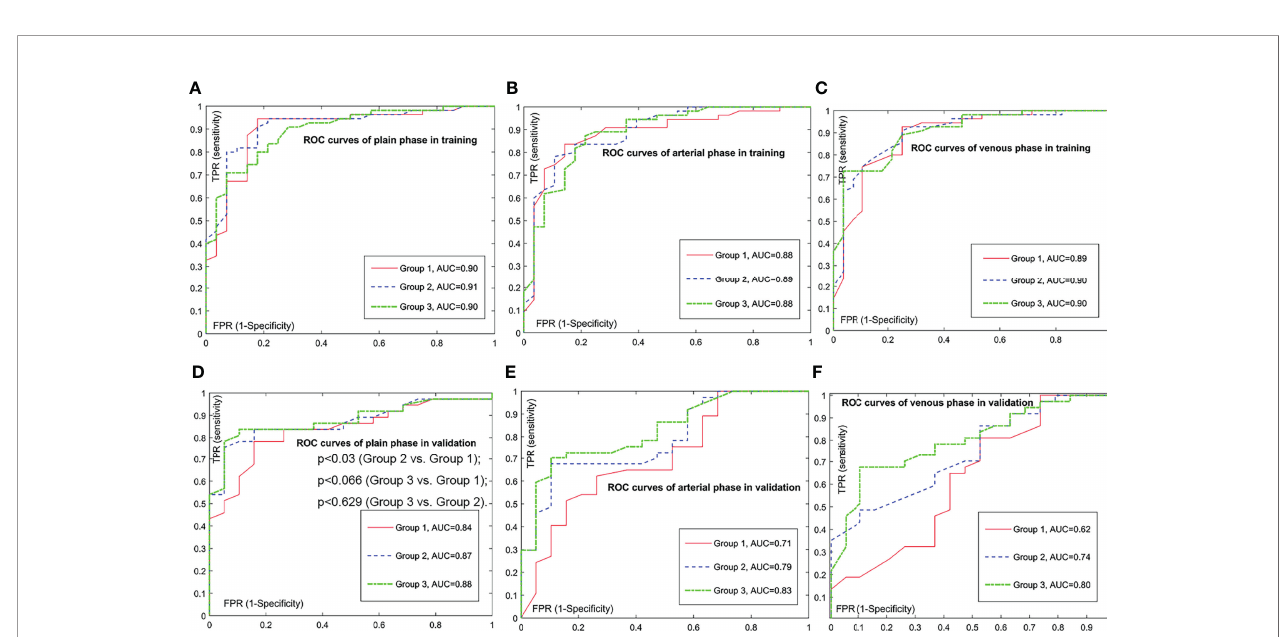
FIGURE 2 | Comparison of receiver operating characteristic (ROC) curves for prediction of the histologic grade. The positive class is grade 2/3; the negative class is grade 1. Sub fi gure (A – C) illustrate the training ROCs. Sub fi gures (D – F) illustrate the validation ROCs. In validations, we performed DeLong ’ s tests to compare two ROC curves. In (D) , the DeLong ’ s tests show that the p -value between the ROC curve of group 3 and the ROC curve of group 1 is less than 0.066, the p -value between the ROC curve of group 3 and the ROC curve of group 2 is less than 0.629, and the p-value between the ROC curve of group 2 and the ROC curve of group 1 is less than 0.030. In sub fi gure (E) , the DeLong ’ s tests show that the p-value between the ROC curve of group 3 and the ROC curve of group 1 is less than 0.003, the p-value between the ROC curve of group 3 and the ROC curve of group 2 is less than 0.037, and the p -value between the ROC curve of group 2 and the ROC curve of group 1 is less than 0.013. In (F) , the DeLong ’ s tests show that the p -value between the ROC curve of group 3 and the ROC curve of group 1 is less than 0.001, the p -value between the ROC curve of group 3 and the ROC curve of group 2 is less than 0.059, and the p -value between the ROC curve of group 2 and the ROC curve of group 1 is less than 0.003.